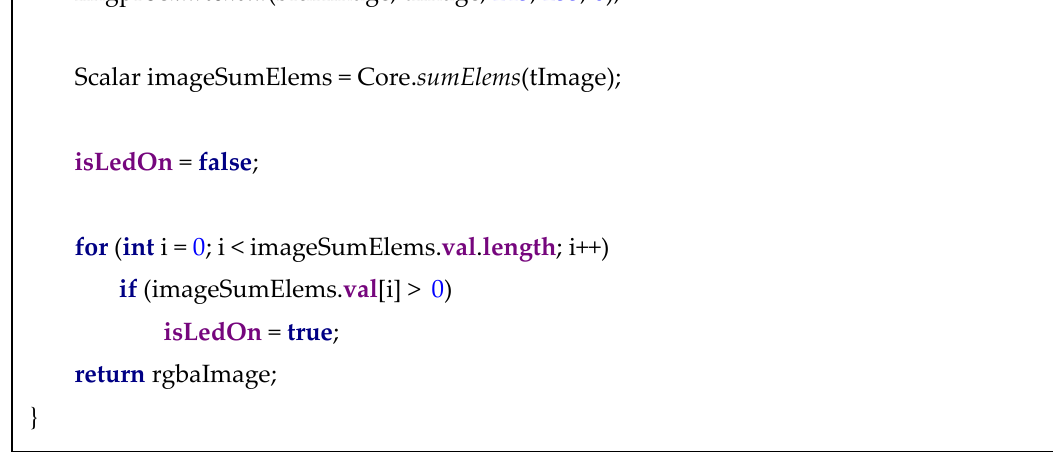
Figure 13. Translation of a blinking LED into a bit string.